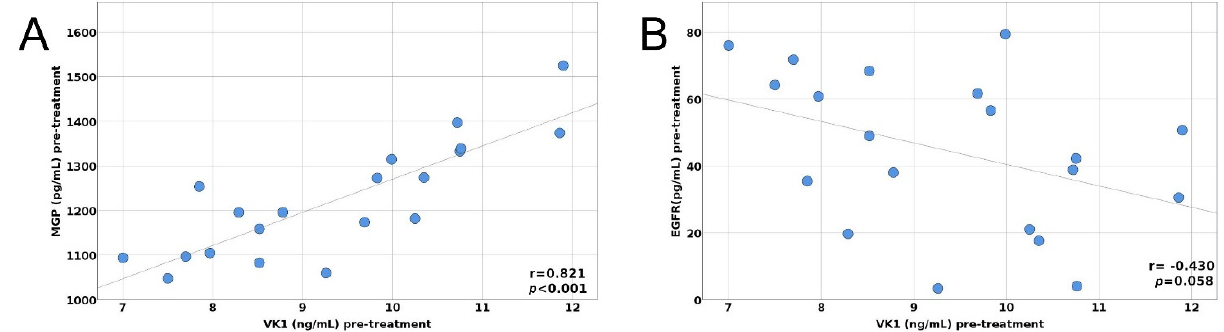
Figure 1. ( A ) Pre-treatment correlation between MGP and VitK 1 , ( B ) Pre-treatment correlation between EGFR and VitK 1 .